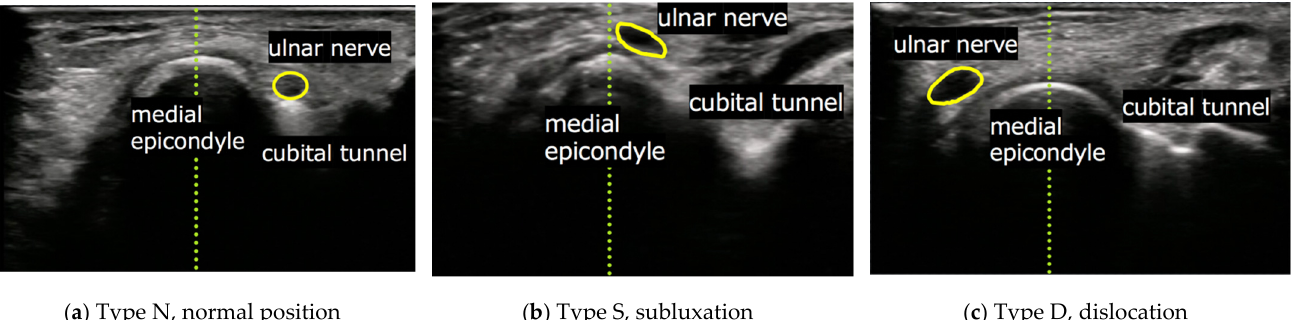
Figure 1. Short axis images at the cubital tunnel by ultrasonography. ( a ) Type N, normal position (ulnar nerve was into the cubital tunnel); ( b ) Type S, subluxation (ulnar nerve was on the tip of the medial epicondyle); and ( c ) Type D, dislocation (ulnar nerve exceed and positioned anteriorly to tip of the medial condyle).